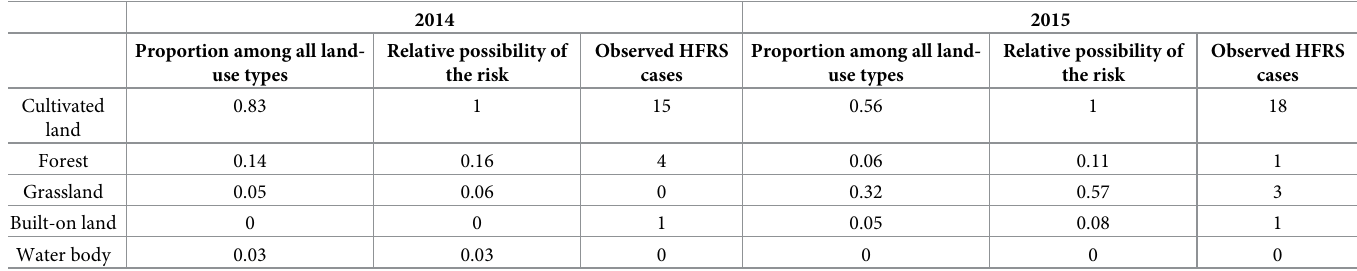
Table 4. Predicted proportions and relative possibility of HFRS incidence risk and the number of observed HFRS cases among the different land-use types in 2014 and 2015. (Off-diagonal data to predict the on-diagonal